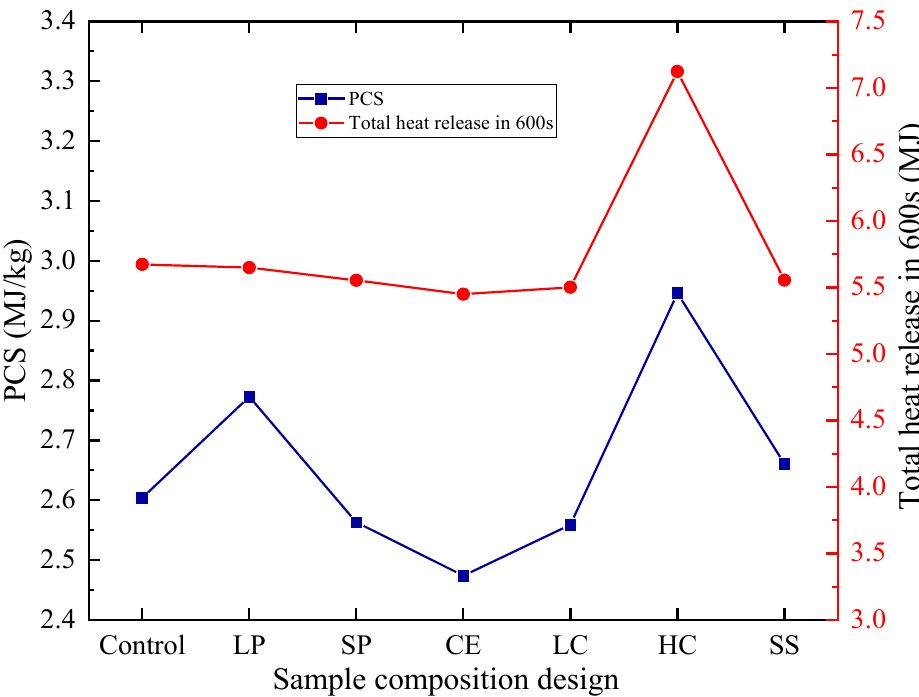
Figure 8. The gross heat of combustion and THR 600 of seven CEPS groups.